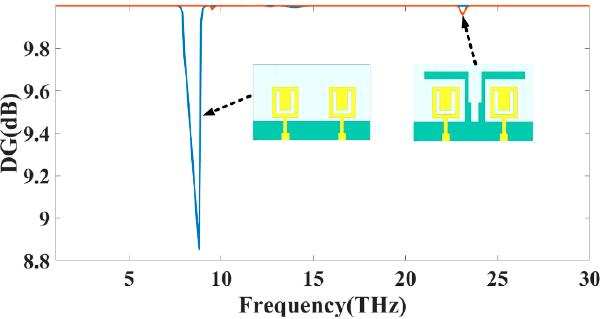
Figure 4. The DG (dB) simulated value for MIMO structure Design 3 and Design 4.